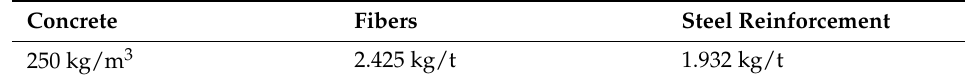
Table 4. CO (cid:2870) emissions per technical solution.